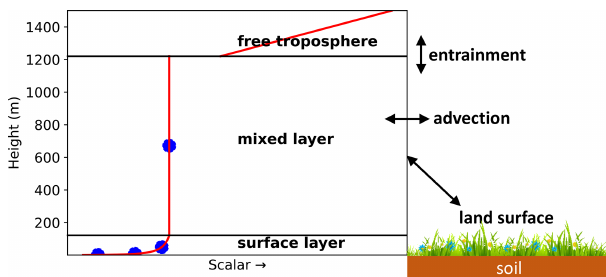
Figure 1. Sketch of the employed forward model (the slightly adapted CLASS model). The blue dots in the surface layer represent user-specified heights, where the model calculates scalars, e.g. the CO 2 mixing ratio. The mixed layer is represented by a single bulk value in the model (blue dot in the mixed layer). At the top of the mixed layer, a discontinuity (jump) occurs in the profiles. The free troposphere is not explicitly modelled but is taken into account for the exchange with the mixed layer (entrainment). The slope of the free troposphere line is the free tropospheric lapse rate. A constant advection can be taken into account as a